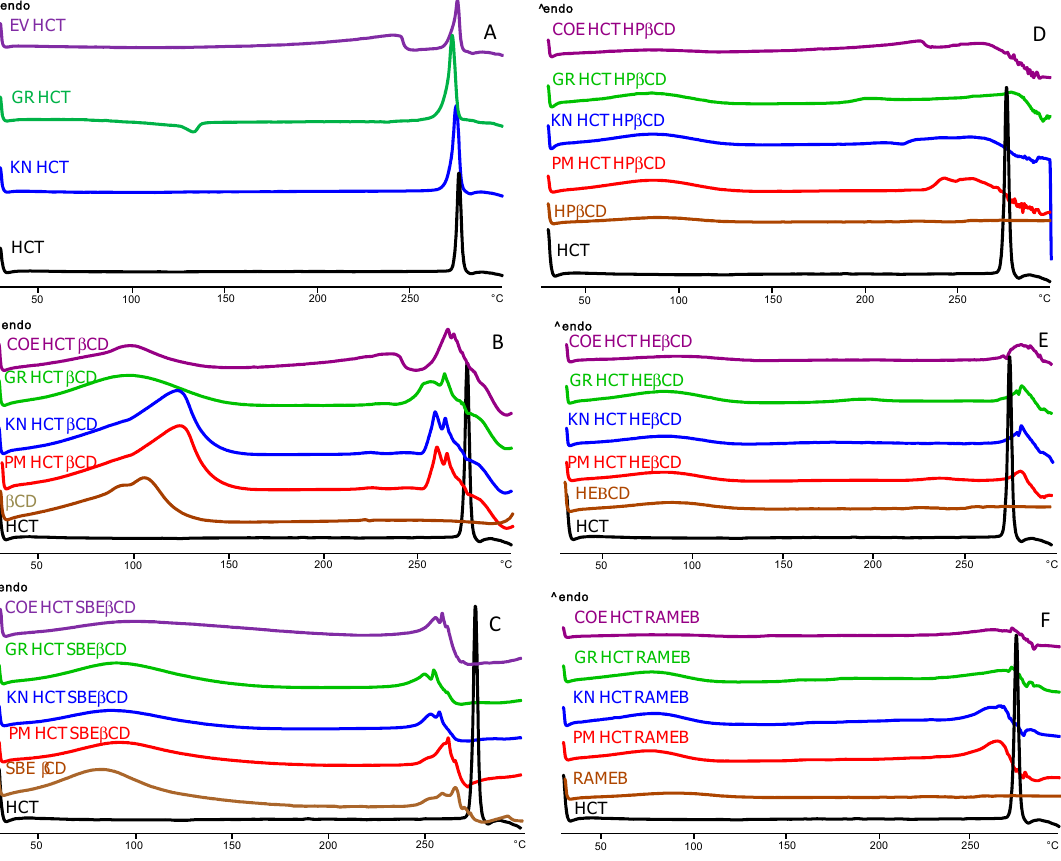
Figure 2. DSC curves of pure HCT ( A ) untreated or submitted to kneading (KN), grinding (GR) or dissolution-solvent evaporation (EV) and its binary systems with β CD ( B ), HP β CD ( C ), HE β CD ( D ), SBE β CD ( E ), and RAMEB ( F ), obtained by physical mixing (i.e., PM), co-grinding (GR), kneading (KN), and co-evaporation (COE).